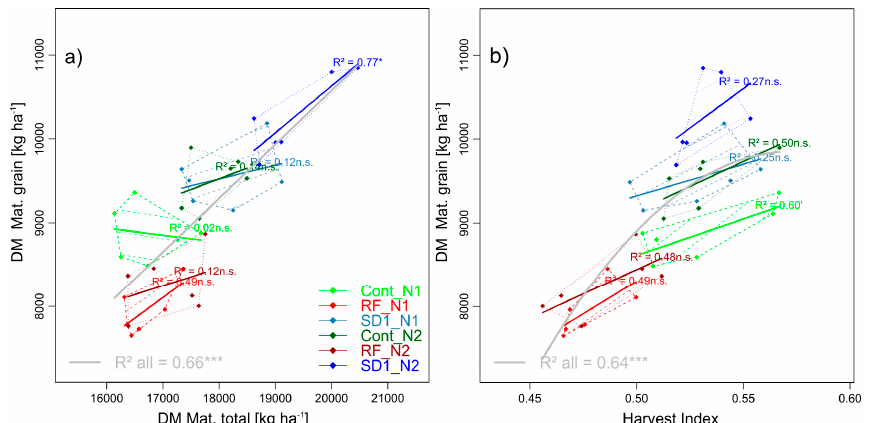
Figure 5. Selected pairwise trait relationships in trait complex d : DM of grain at maturity (GY) in relation to its two multiplicative components total dry matter at maturity (DM Mat. total, ( a )), and harvest index (unitless, ( b )). N levels are distinguished by line types and color intensities (N1: Dashed lines and light colors, N2: Dotted lines and dark colors). Dashed and dotted lines delimit the bivariate data range covered by cultivars within MP × N-combinations. Colored regression lines indicate the linear trait relationships within MP × N-combinations and gray lines the regression line for the whole trial, calculated across the included data of reduced fungicide (RF), control (Cont) and sowing date 1